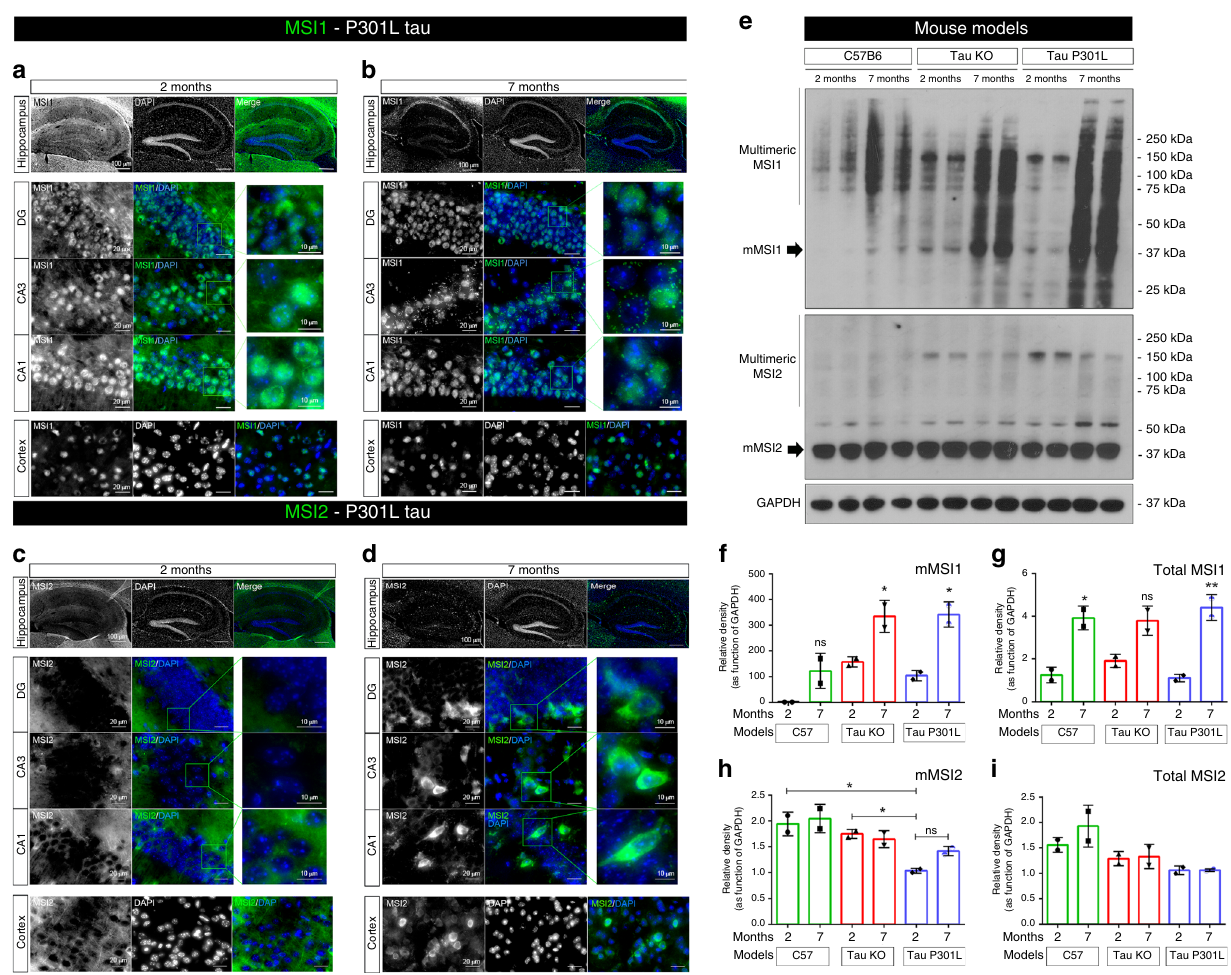
Fig. 4 MSI proteins in hippocampus and cortex of P301L tau mouse model. a Representative MSI1 (gray/green) immuno fl uorescence of 2-month P301L hippocampus (10X, white scale bar: 100 µ m). High Magni fi cation images (100X) of DG, CA3, CA1 and Cortex are presented (white scale bar: 20 µ m). b Representative MSI1 (gray/green) immuno fl uorescence of 7-month P301L hippocampus (10X, white scale bar: 100 µ m). High Magni fi cation images (100X) of DG, CA3, CA1 and Cortex are presented (white scale bar: 20 µ m). c Representative MSI2 gray/green) immuno fl uorescence of 2-month P301L hippocampus (10X, white scale bar: 100 µ m). High Magni fi cation images (100X) of DG, CA3, CA1, and Cortex are presented (white scale bar: 20 µ m). d Representative MSI2 gray/green) immuno fl uorescence of 7-month P301L hippocampus (10X, white scale bar: 100 µ m). High Magni fi cation images (100X) of DG, CA3, CA1, and Cortex are presented (white scale bar: 20 µ m). For all the images, MSI2 is presented in gray channel and in the merge MSI2 is presented (Nuclei are stained with DAPI, blue). All zoomed images of DG, CA3 and CA1 have a white scale bar of 10 µ m ( e ) MSI1, MSI2, and GAPDH immunoblots in 2- and 7-month-old mouse brain homogenates (C57, tau KO, and tau P301L models). Immunoblot samples are presented in duplicate. f – g Relative density of monomeric and total MSI1, respectively is presented (Monomeric MSI1 One-way ANOVA, Tukey ’ s multiple comparisons test has been performed ( p -value = 0.0014 between the columns, for total MSI1 p = 0.0014). Data are presented as mean ± SD. h , i Relative density of monomeric and total MSI2 respectively is presented. All relative density are in function of GAPDH. One-way ANOVA, Tukey ’ s multiple comparisons test has been performed to compare MSI relative amounts among the ages and models (monomeric MSI2 p = 0.0084, for total MSI2 p = 0.0415). Sample size for data in ( f – i ) is n = 3 biologically independent samples examined over three independent experiments, two independent samples are shown in the WB. Data are presented as mean ±